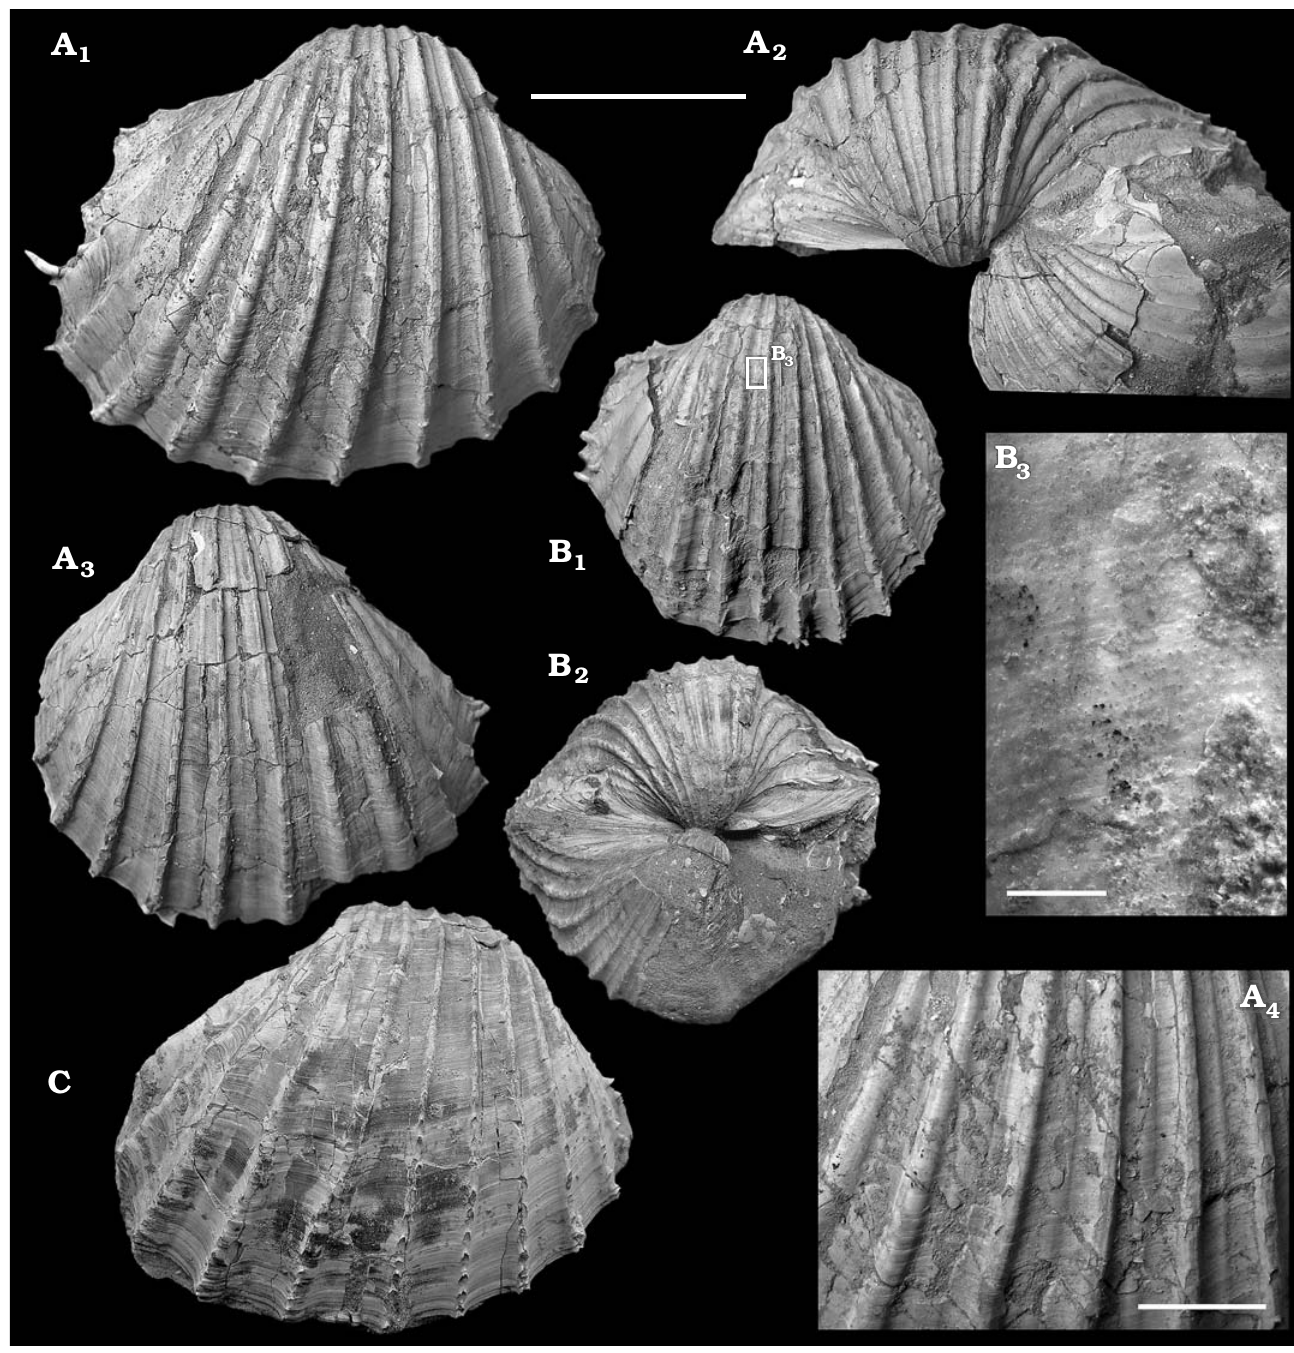
Fig. 11. Cardiid bivalve Procardium danubianum (Mayer, 1866) from Badenian (Miocene) of Enzesfeld, Austria. A . Lectotype of Cardium danubianum Mayer, 1866, NHMW 1853.XVI.44, external (A 1, A 3 ) and umbonal (A 2 ) views, detail of sculpture (A 4 ). B . Paralectotype, NHMW 1853.XVI.43, external (B 1 ) and umbonal (B 2 ) views, detail of microsculpure (B 3 ). C . NHMW 1853.XVI.41, external view. Photos Oleg Mandic. Scale bars: A 1 –A 3 , B 1 , B 2 , C, 50 mm; A 4 , 20 mm; B 3 , 1